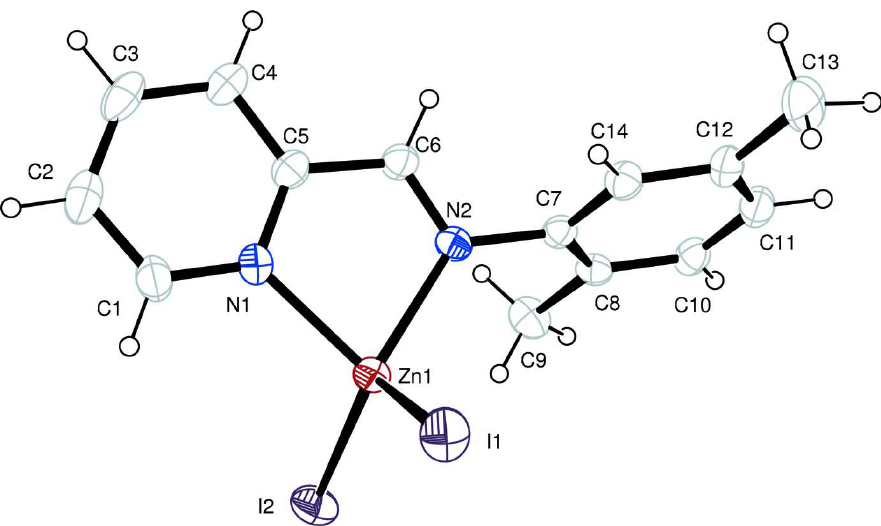
The molecular structure of the title molecule, with the atom-numbering scheme. Displacement ellipsoids are drawn at the 30% probability